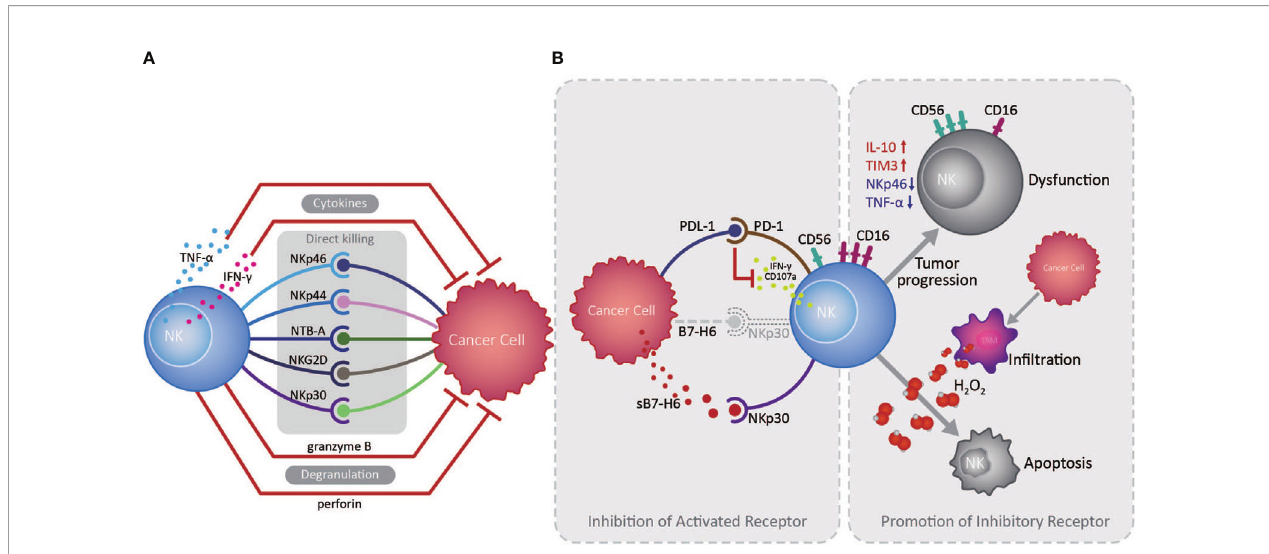
FIGURE 1 | Roles of natural killer cells in the esophageal cancer tumor microenvironment. (A) Natural killer (NK) cells exert essential anti-tumor functions through degranulation, cytokine release, and activated receptor expression, directly killing esophageal tumor cells in the absence of antigen recognition in the tumor microenvironment (TME). (B) Cancer cells can escape from NK cell immune surveillance in the TME through the PD-1/PD-L1 pathway and the competitive combination of activated NKp30 receptor, expressed on NK cells, by releasing soluble B7-H6 (indicated as sB7-H6). Otherwise, large amounts of H 2 O 2 produced by tumor in fi ltrated macrophages in the TME are prone to induce CD56 dim NK cell apoptosis, while CD56 dim NK cells can also transform to a CD56 bright phenotype during tumor development, as well as decreasing in number and becoming